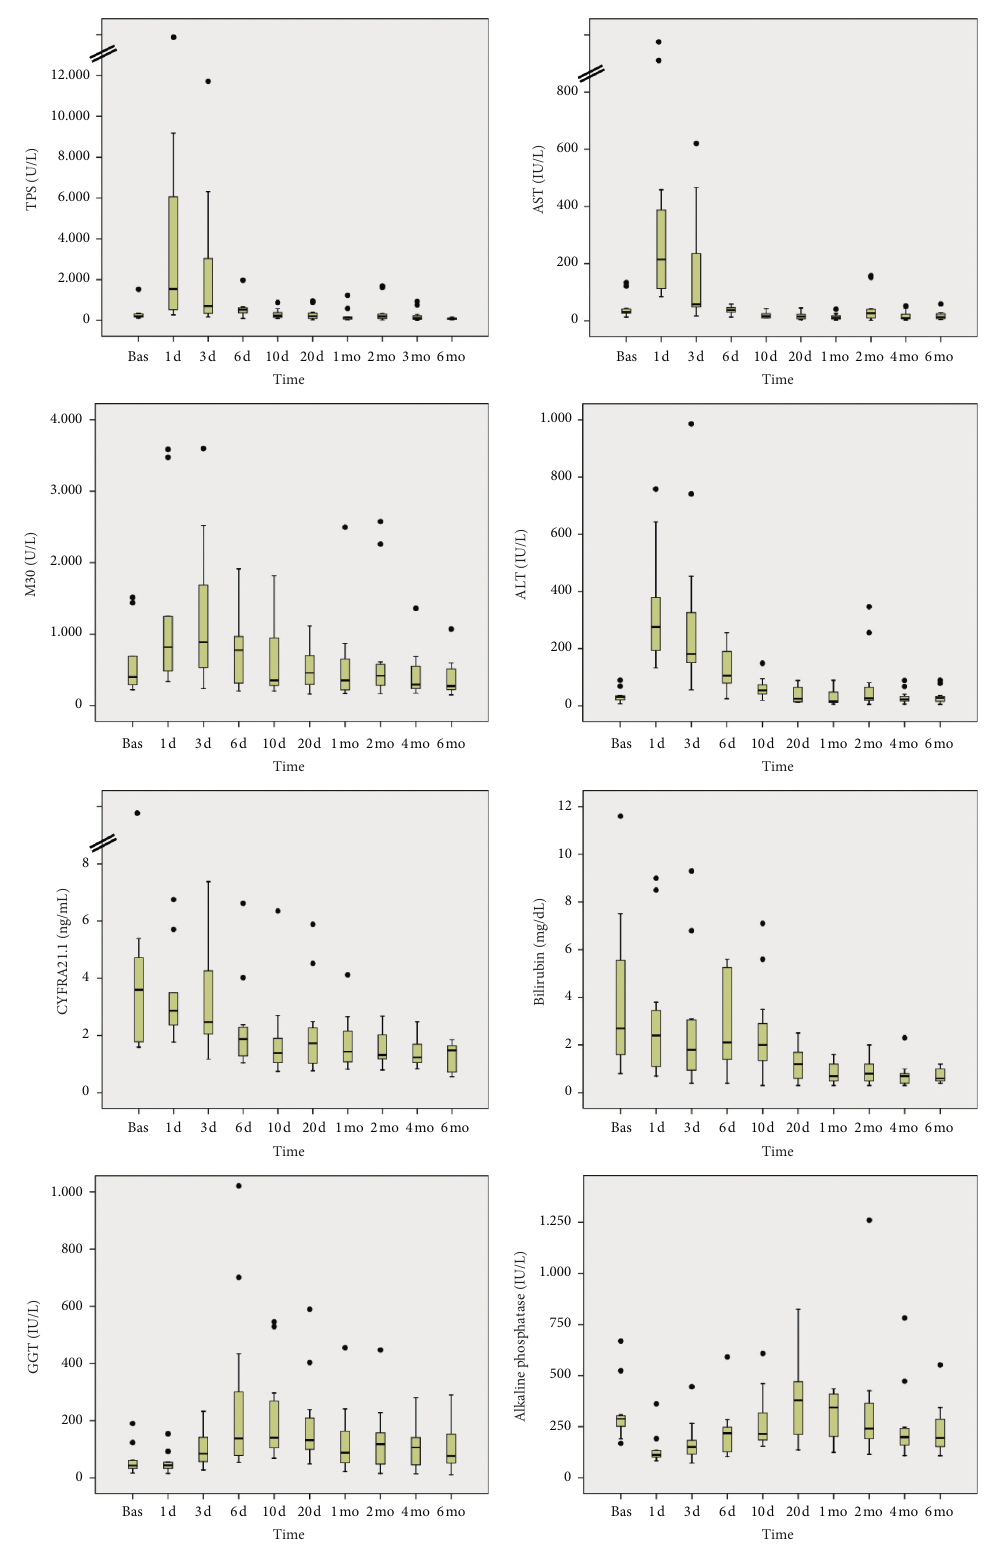
Figure 2: Time-course changes in serum concentrations of the K18 fragments TPS and M30 and the K19 fragment CYFRA 21-1 after liver transplantation. Comparison with time-course changes in the standard liver markers serum AST, ALT, GGT, alkaline phosphatase, and total bilirubin. Bas, baseline (pretransplant level); d, day; mo,